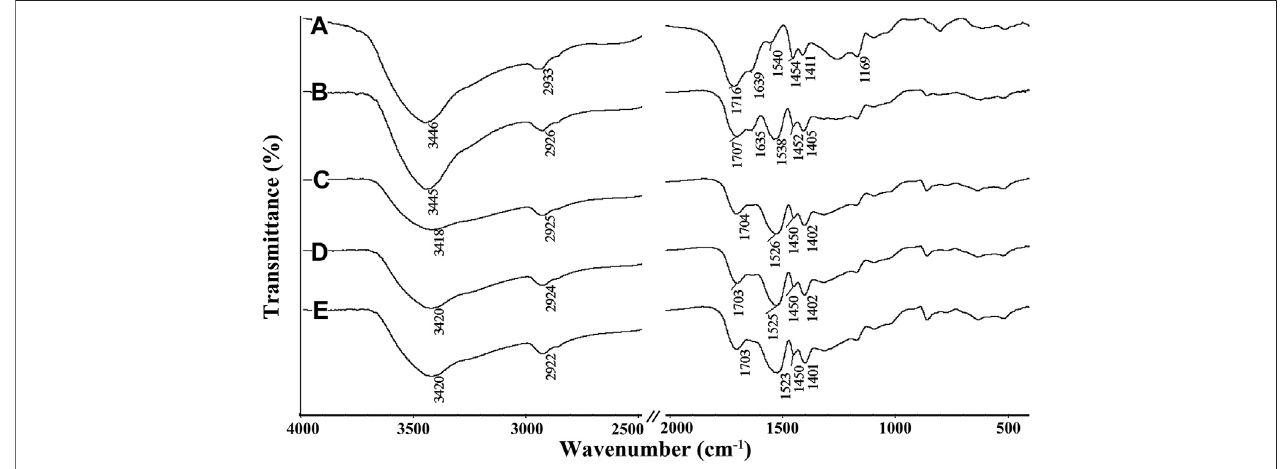
FIGURE 8 | FTIR spectra of Semi-IPN2 adsorbent after adsorption of Pb(II) at the pH values of (A) 3, (B) 3.5, (C) 4, (D) 4.5, and (E) 5.